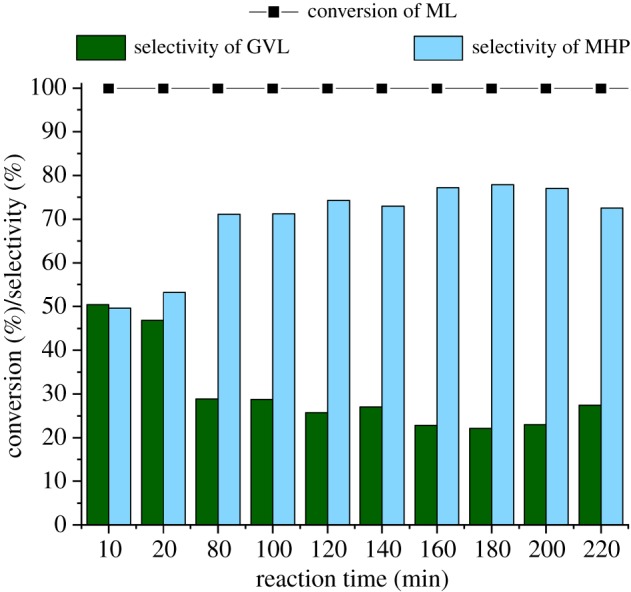
Continuous conversion of ML to GVL in water. Conditions: Csubstr = 0.1 M, p = 100 bar, T = 100°C, flow rate = 1 ml min–1.